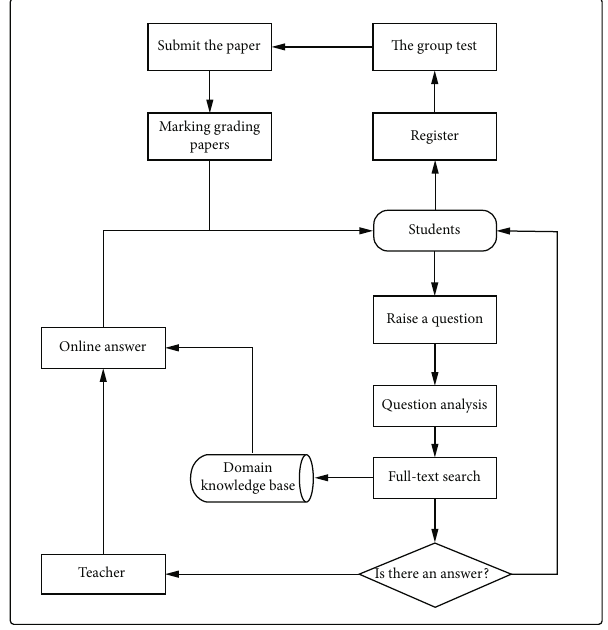
Figure 1: Flow chart of question-answering self-test system based on arti fi cial